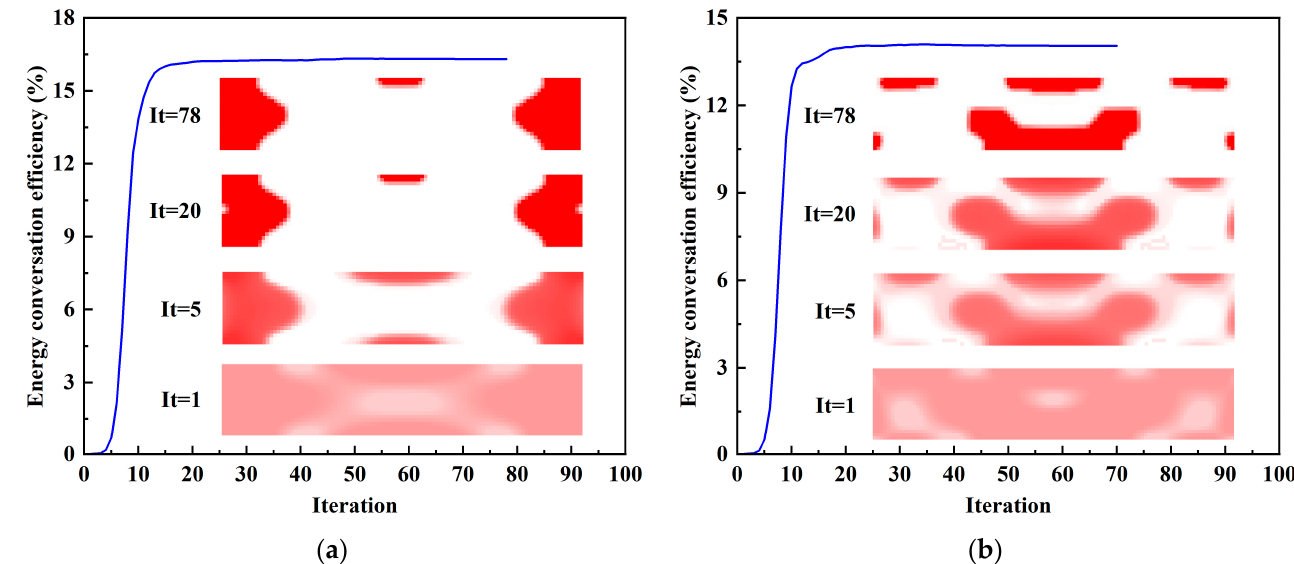
Figure 6. Iterative history and topological evolution for energy conversion efficiency designs. ( a ) f = 4 kHz; ( b ) f = 16 kHz.